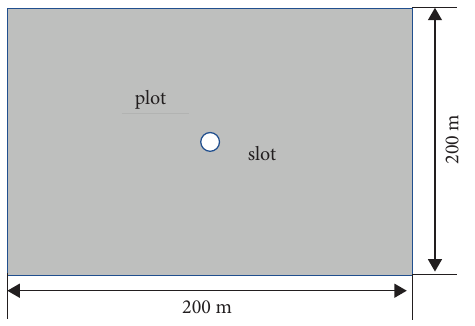
Figure 8: Numerical model for hydraulic fracturing of coal seam.